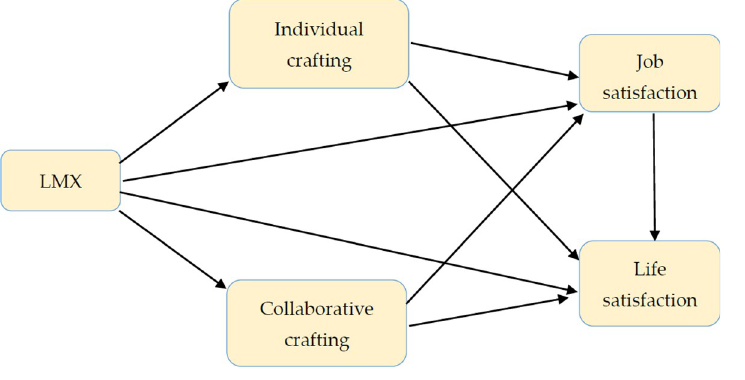
Fig 1. The proposed